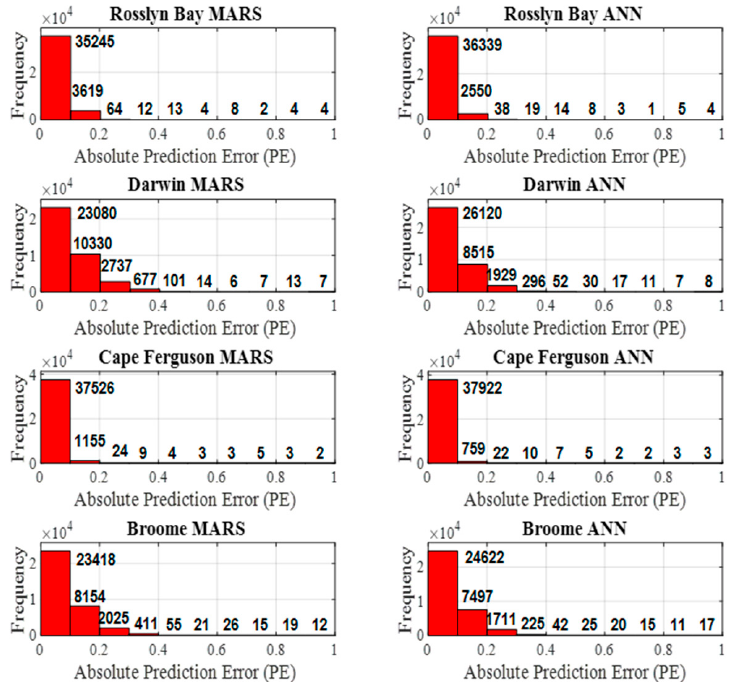
Figure 9. Histograms show the absolute prediction error distribution bars of the MARS and ANN model.